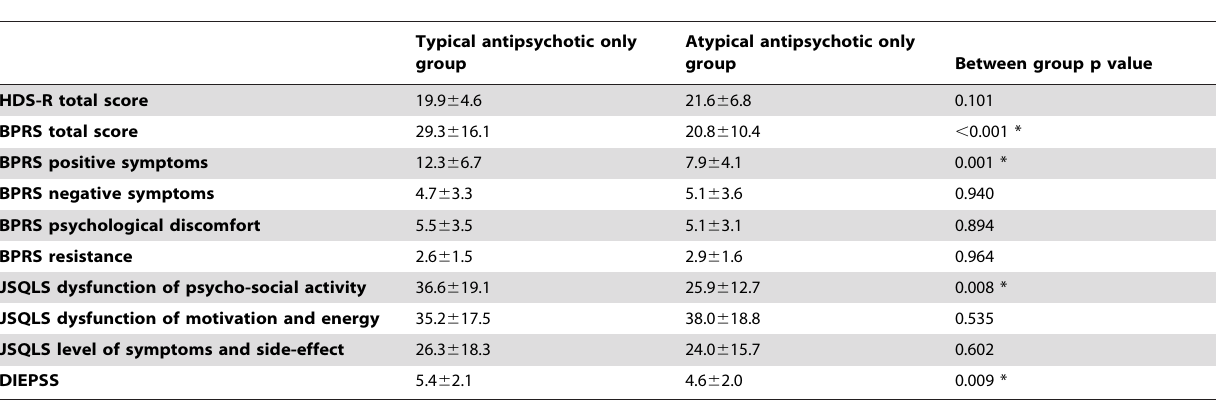
Table 6. Comparison of each scale between patients receiving typical and atypical antipsychotics.